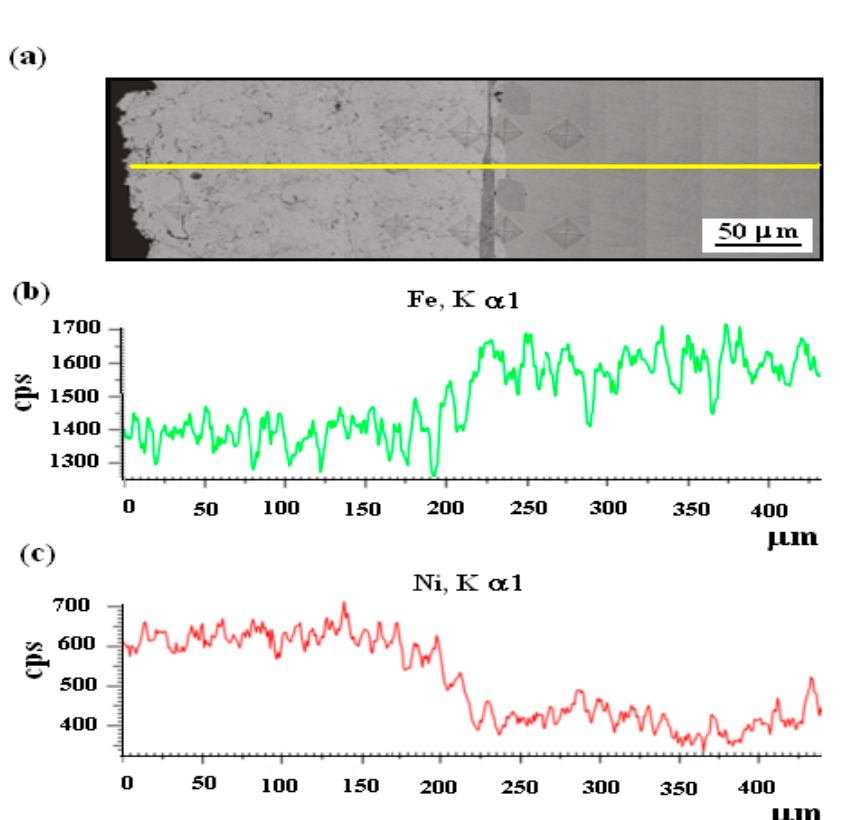
Figure 4. X-ray microanalysis of cross-section of PIn coating and substrate: ( a ) Metallographic microstructure (with the line scanning), and content distribution; ( b ) Iron, and ( c ) Nickel.